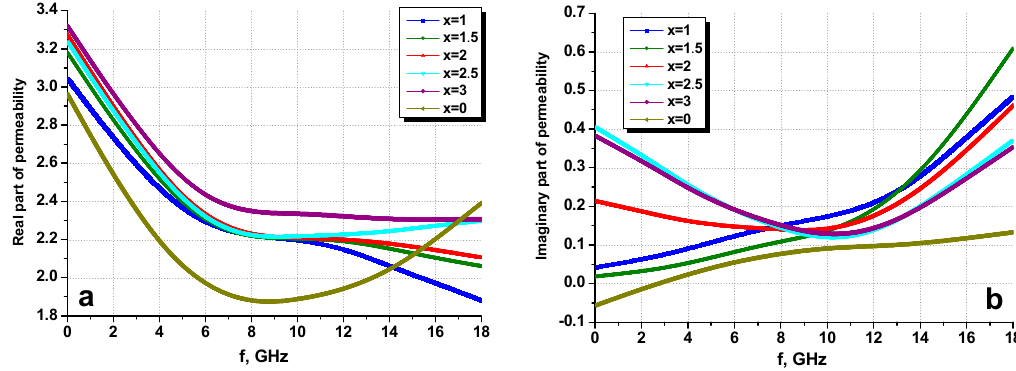
Figure 11. Frequency dispersions of the real part ( a ) and imaginary part ( b ) of permeability for the SrBaSmFe/(NiZnFe) x NCs.